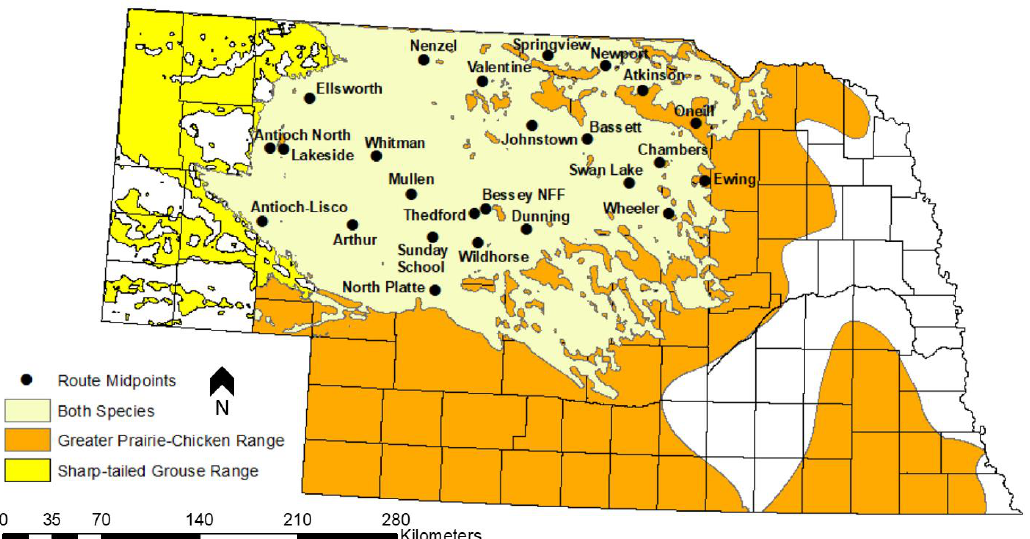
Figure 1. Geographic midpoints of the 25 historical prairie grouse breeding ground survey routes that fall within the Sandhills of Nebraska, USA. The boundaries of the Sandhills are roughly approximated by the spatial extent of the beige polygon representing shared prairie grouse range. Adapted from a figure created by J. Dallmann, Nebraska Game and Parks